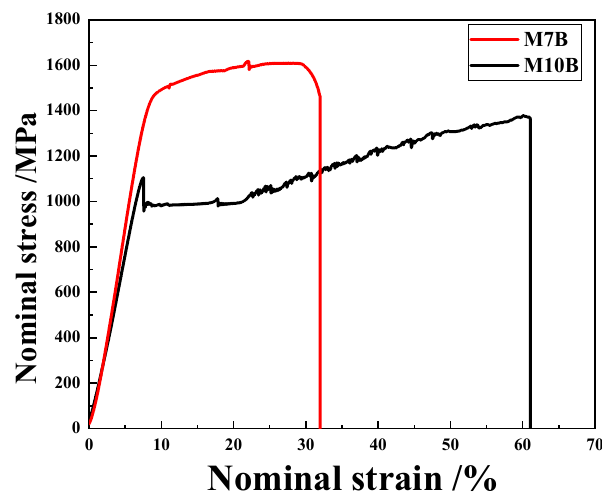
Figure 2. Engineering stress–strain curves of M7B and M10B.